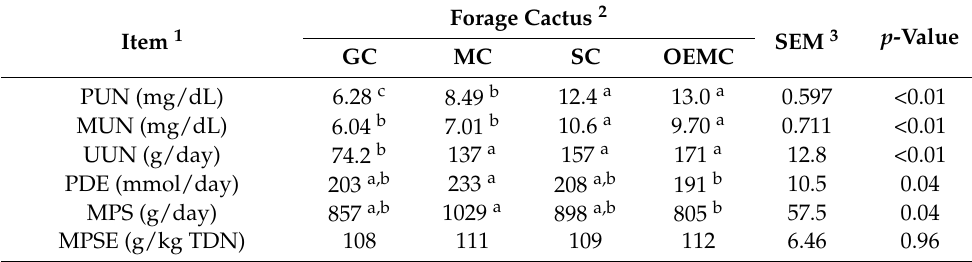
Table 7. Effects of forage cactus genotypes on urea excretion and microbial protein synthesis ( n =